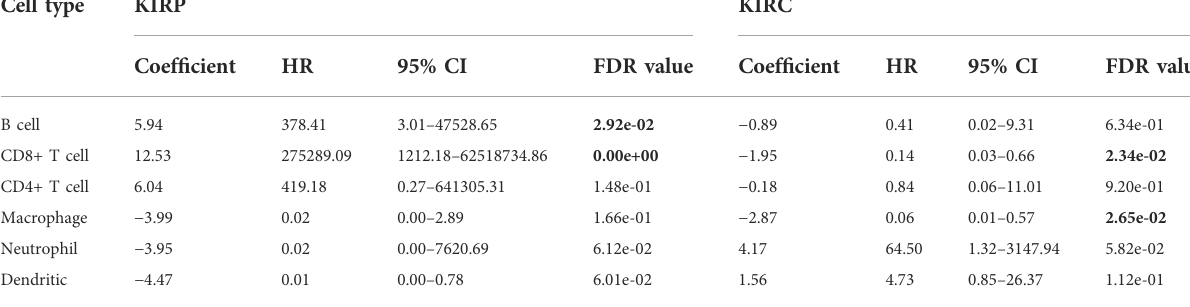
TABLE 1 The Cox proportional hazard model of six tumor-in fi ltrating immune cells in KIRP and KIRC. Cell